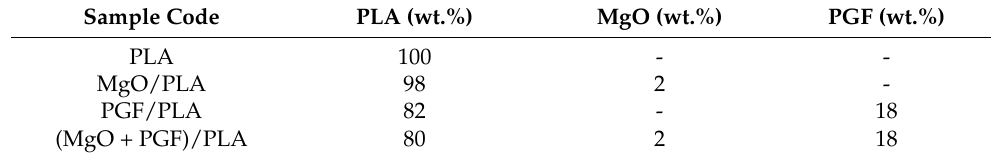
Table 1. Sample codes and material compositions of filament feedstocks for additive